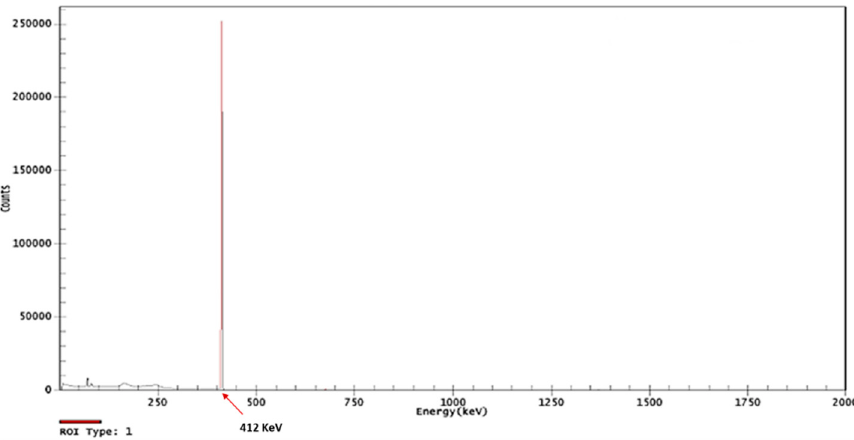
Figure 1. Gamma spectrometry using an HPGe detector from the 198 Au, corroborating the efficacy of the irradiation process in forming [ 198